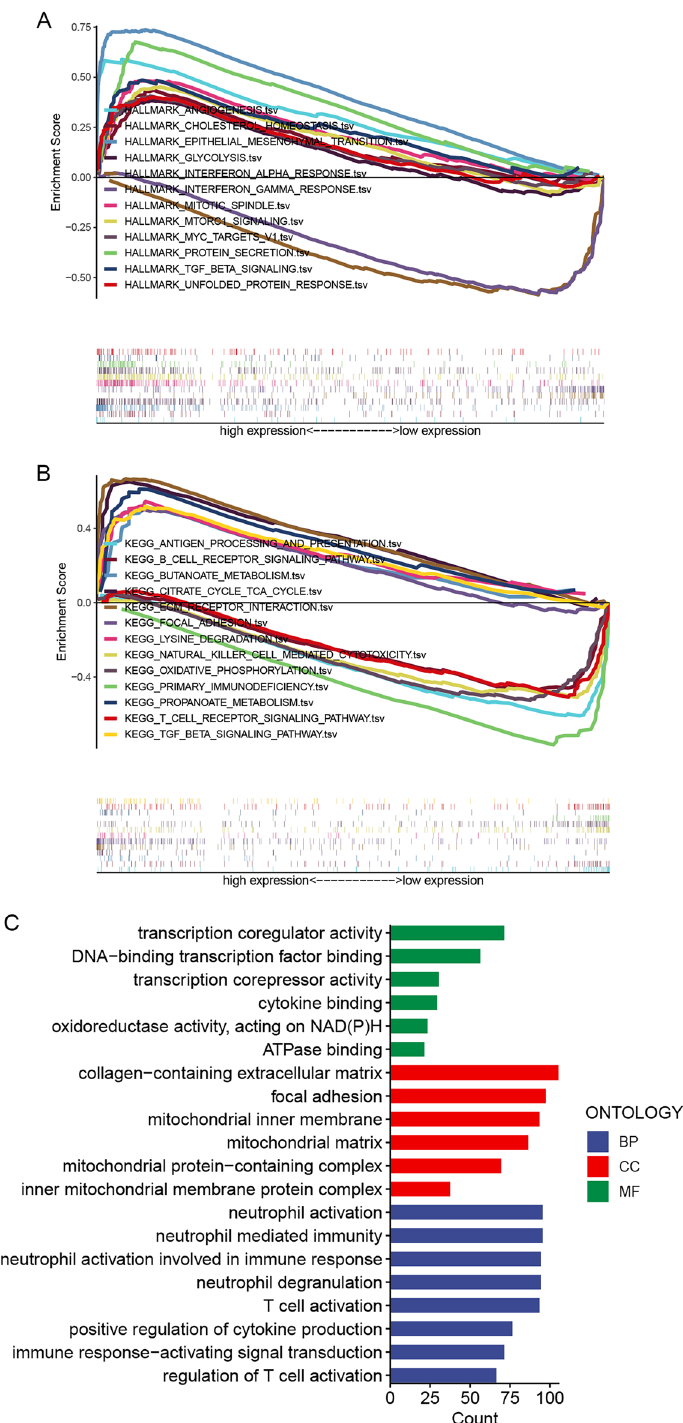
Figure 7. Functional enrichment analysis of higher-risk and lower-risk groups based on the mitochondrial function-related lncRNA prognostic signature. ( A ) GSEA results show significant enrichment of metabolic- related pathways in higher-risk BRCA patients. ( B ) KEGG results show significant enrichment of metabolic- related pathways in the higher-risk group, and the immune-related pathways were activated in the lower-risk BRCA patients. ( C ) GO results show the DElncRNAs between higher and lower-risk groups majorly enriched in the mitochondrial function-related and immunoregulatory-related functions and